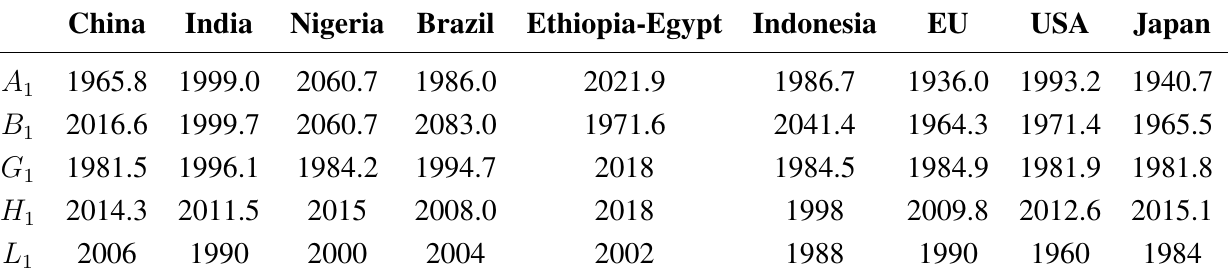
Table 1. Inflection dates for logistic functions.